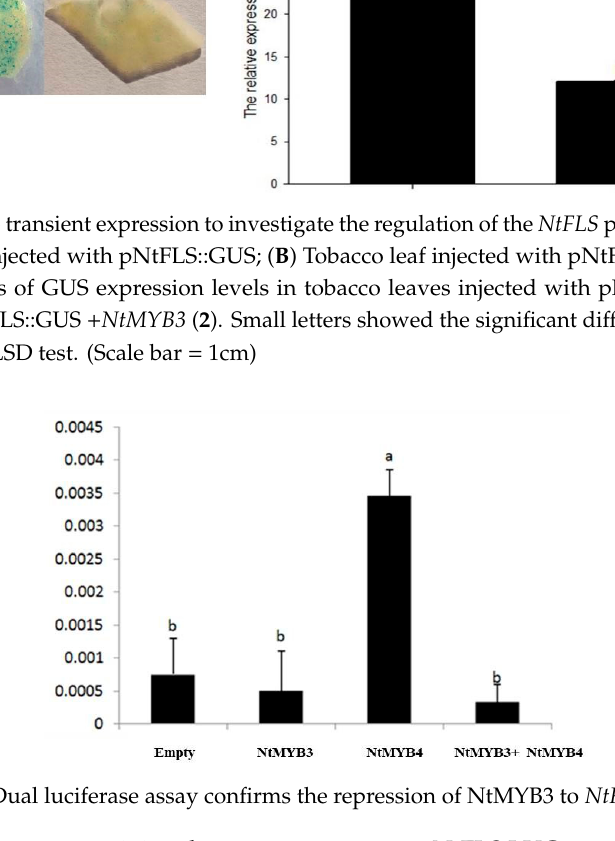
Figure 9. Expression analysis of NtMYB3 in various tissues of Narcissus tazetta . P, C, L, S, and BP indicate the petals, corona, leaves, bulb scales, and basal plates, respectively. Small letters showed the significant di ff erence among di ff erent tissues at the level of p < 0.05 by using LSD test. Bars showed the standard error of three replicates.